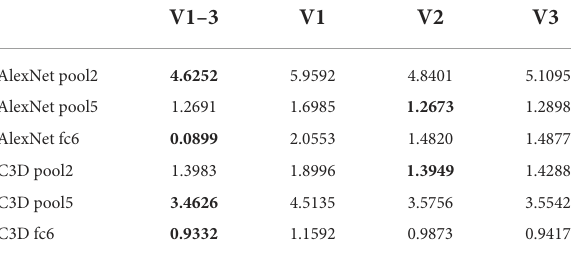
TABLE 4 ROI experiment distance values .